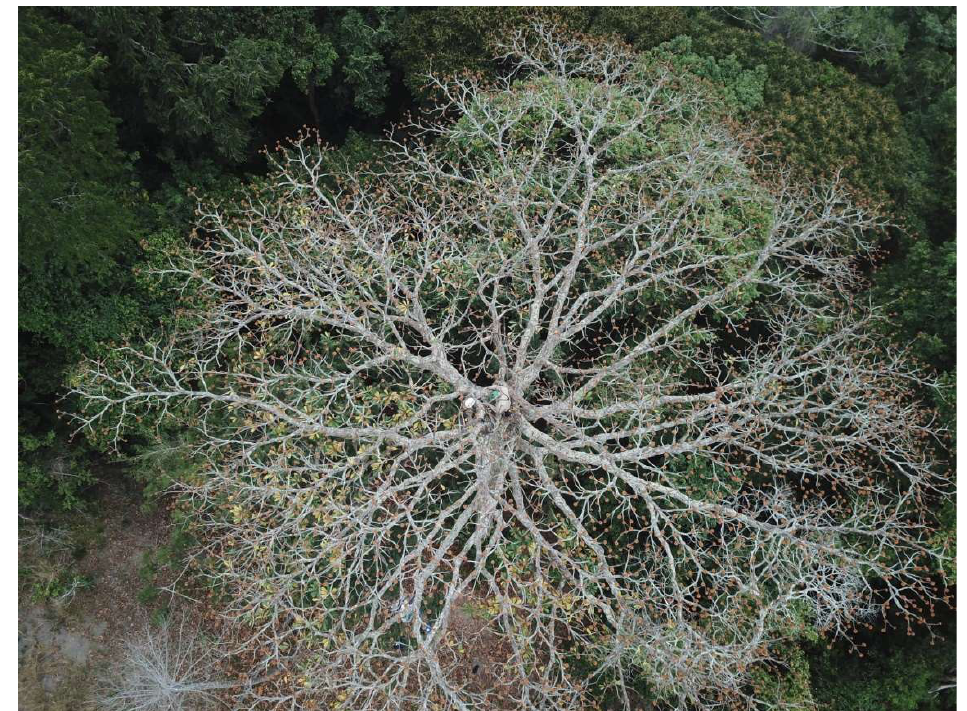
Figure 8. A recent close-range aerial image of a defoliated Moabi crown at Lopé National Park. Photo by David Lehmann.